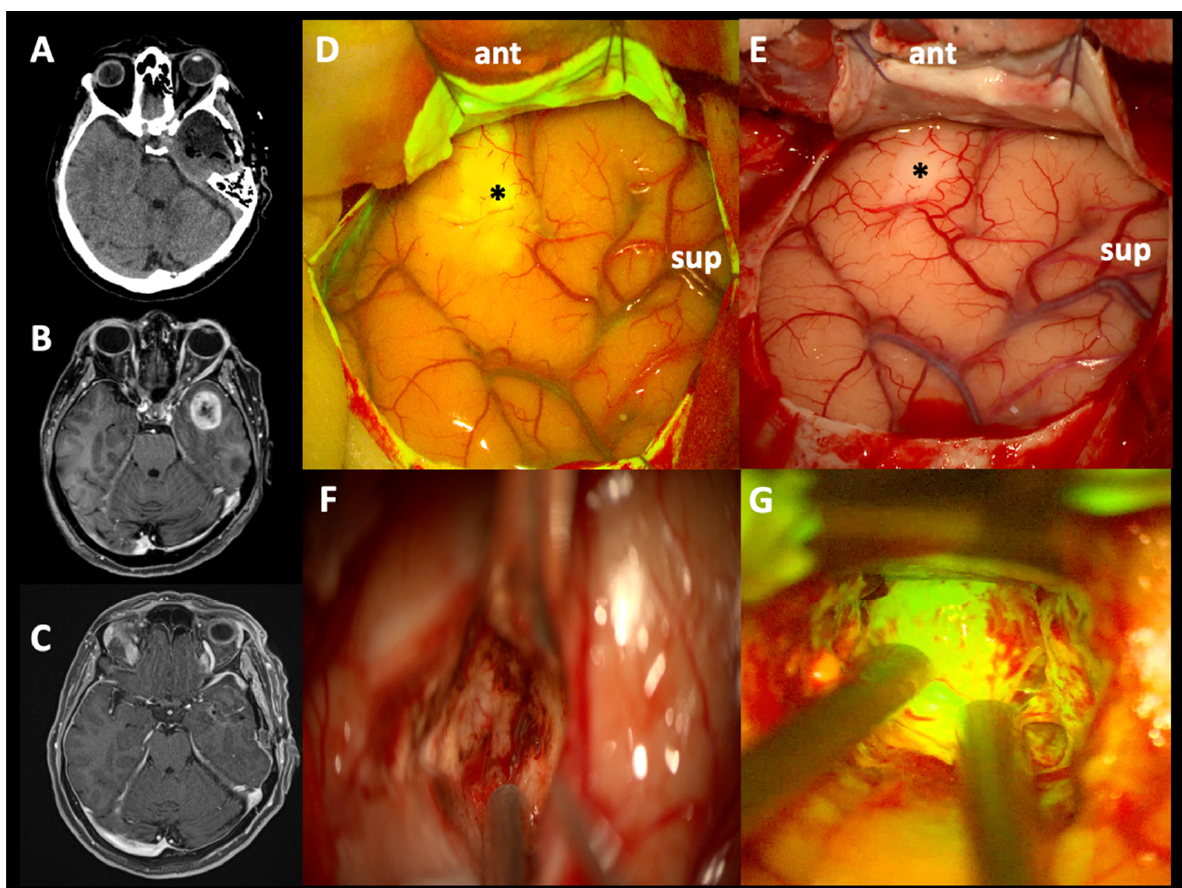
Figure 3. ( B ) Preoperative post-contrast axial T1-weighted MRI scan showing a left temporal GBM, that was completely removed, as visible in post-operative T1 with a contrast axial scan ( C ). A left temporal approach was performed; the craniotomy was executed by means of a basal burr hole and craniotome, as visible in the postoperative axial CT scan ( A ). Intraoperatively, after dural opening with anterior hinge, it is possible to appreciate both under with light (asterisk in ( E )) and after YELLOW 560 filter activation (asterisk in ( D )) a small temporobasal contusion which appeared brightly fluorescent. Despite this eventuality, the YELLOW 560 filter maintained its utility in tumor recognition ( G ), highlighting pathological fluorescent tissue when compared to white light visualization ( F